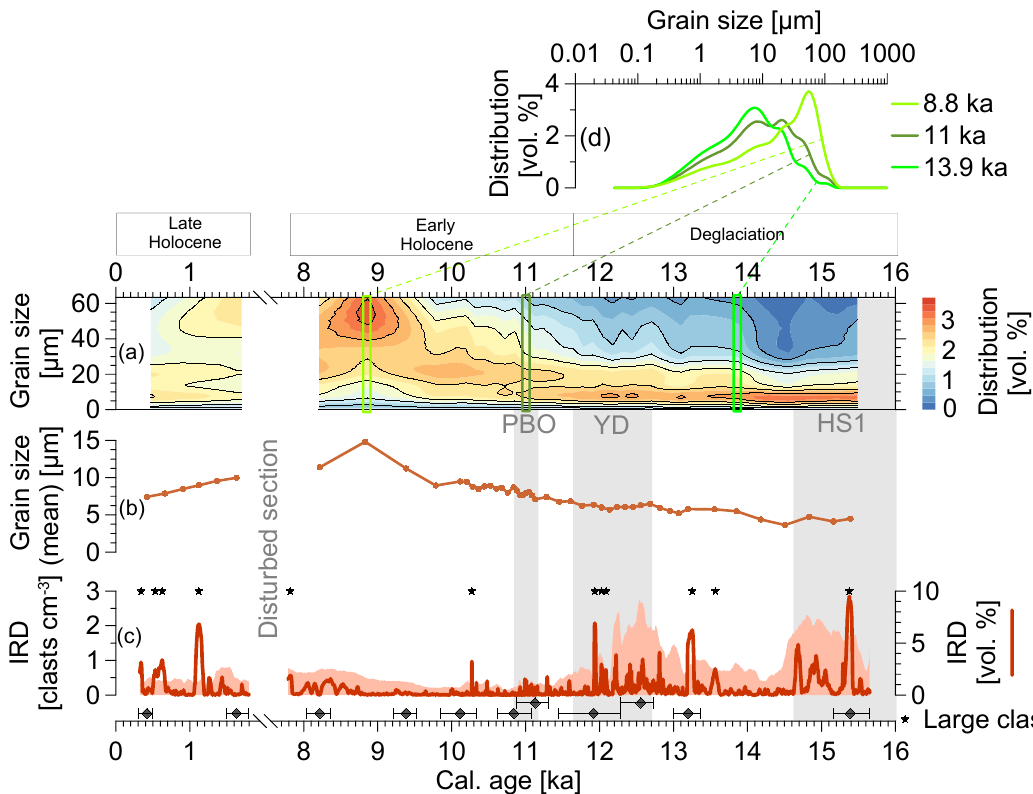
Figure 4. (a) Grain size distribution [vol.%] of fine siliciclastic sediments (0–63µm) derived from laser diffraction particle size analy- ses. Green rectangles: selected grain size distributions as shown in (d) . (b) Mean grain size [µm] of siliciclastic sediments. (c) Ice-rafted debris (IRD): volume percentage (solid red line) and clasts per cubic centimetre (reddish shading) derived from CT analysis. Stars mark peaks in vol.% corresponding to single large clasts. Grey vertical shadings indicate cold periods: Preboreal Oscillation (PBO), Younger Dryas (YD) and Heinrich Stadial 1 (HS1). Dark grey diamonds: calibrated radiocarbon dated depths with error ranges. (d) Selected grain size distributions [vol.%] at ∼ 8.8ka (light green line), ∼ 11 ka (dark green line) and ∼ 13.9 ka (green